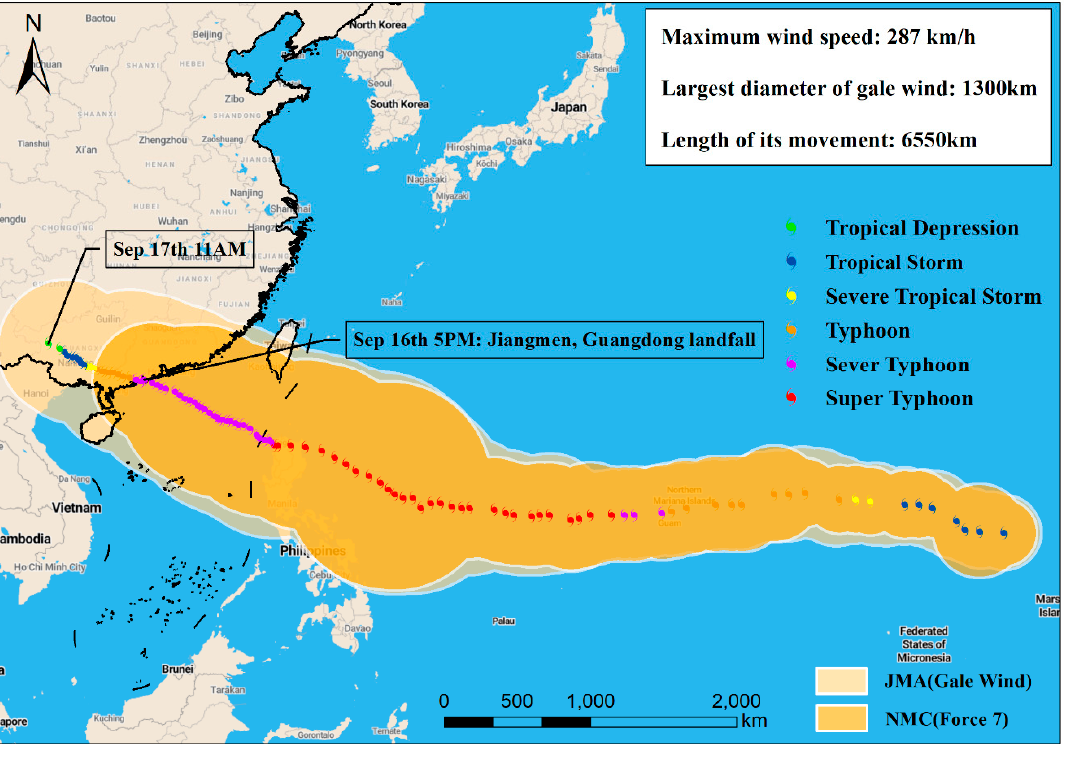
Figure 1. Best track map of the Typhoon Mangkhut. Note: The time zone here is UTC+8.